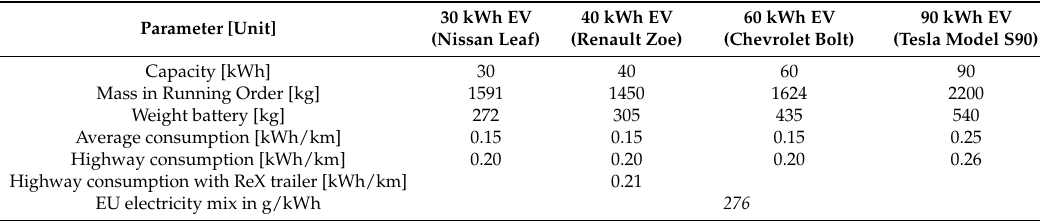
Table 1. Specifications of the discussed electric vehicles (based upon [47]).